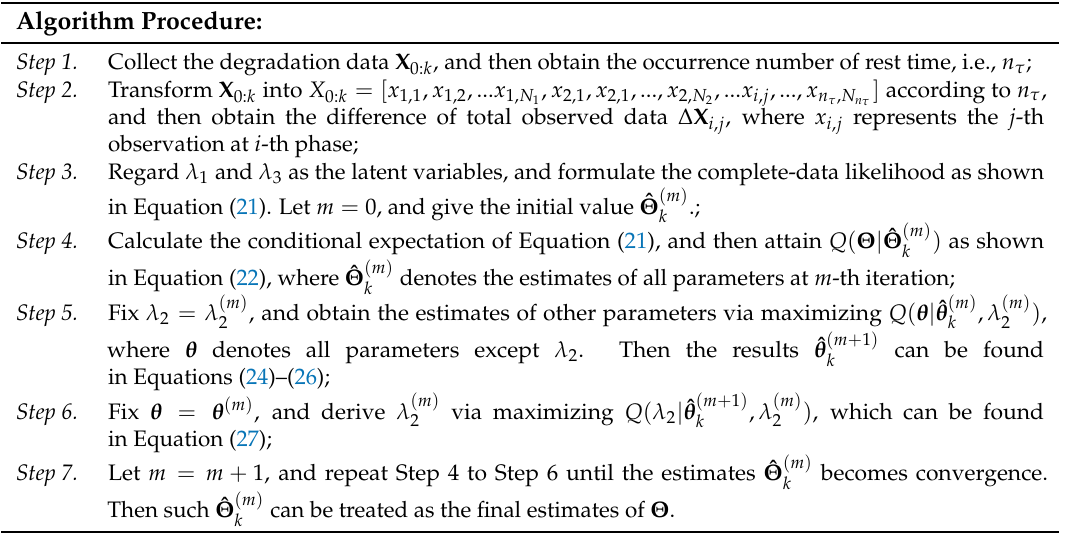
Table 1. The implementation procedures of model